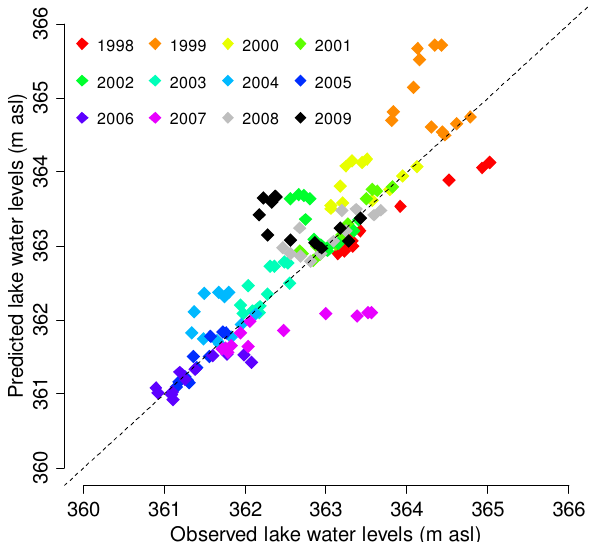
Fig. 5. Cross-validation of lake levels forecasted using nonparamet- ric bootstrap resampling (NBR) technique. Lake levels are predicted for each year using data from other years. For example, lake levels for 2006 are predicted using data from 1998–2005 and 2007–2009. The dotted line is the 1:1